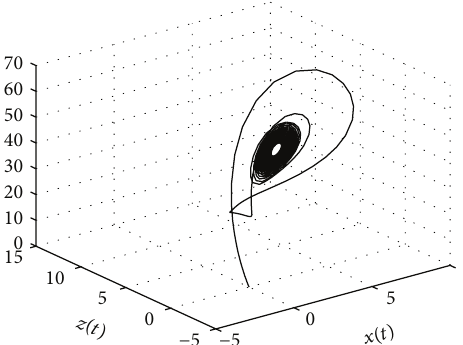
Figure 9: A Hopf bifurcation occurs at the steady state 𝑆 0 of system (5), when 𝑘 1 = − 20 . 3, 𝜏 1 = 0 .